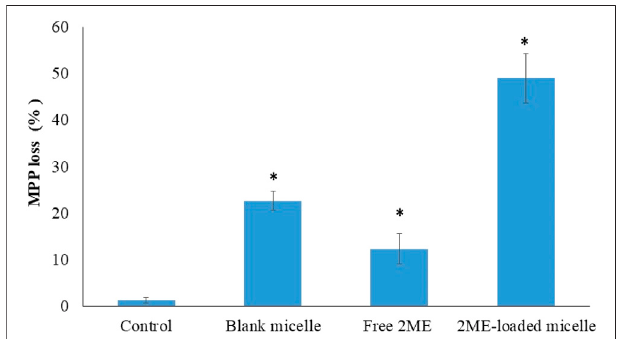
FIGURE8| Lossofmitochondrialmembranepotential(MMP)ofthePC- 3 cells following incubation with blank micelles, free-2 ME and 2 ME-loaded micelles and vehicle control cells. * represents signi fi cant difference from control group ( p < 0.05). Values are expressed as mean ± SD ( n (cid:2) 3).